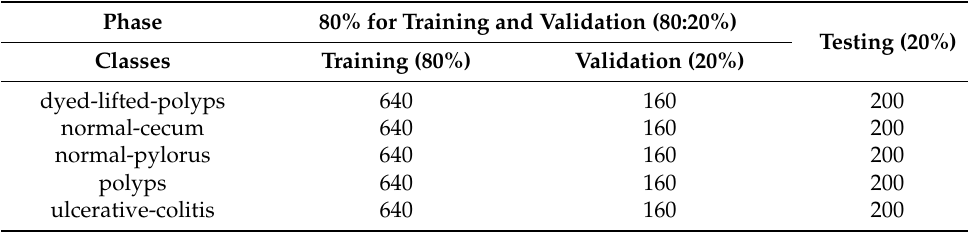
Table 1. Splitting of the endoscopy image of lower GI dataset for training and